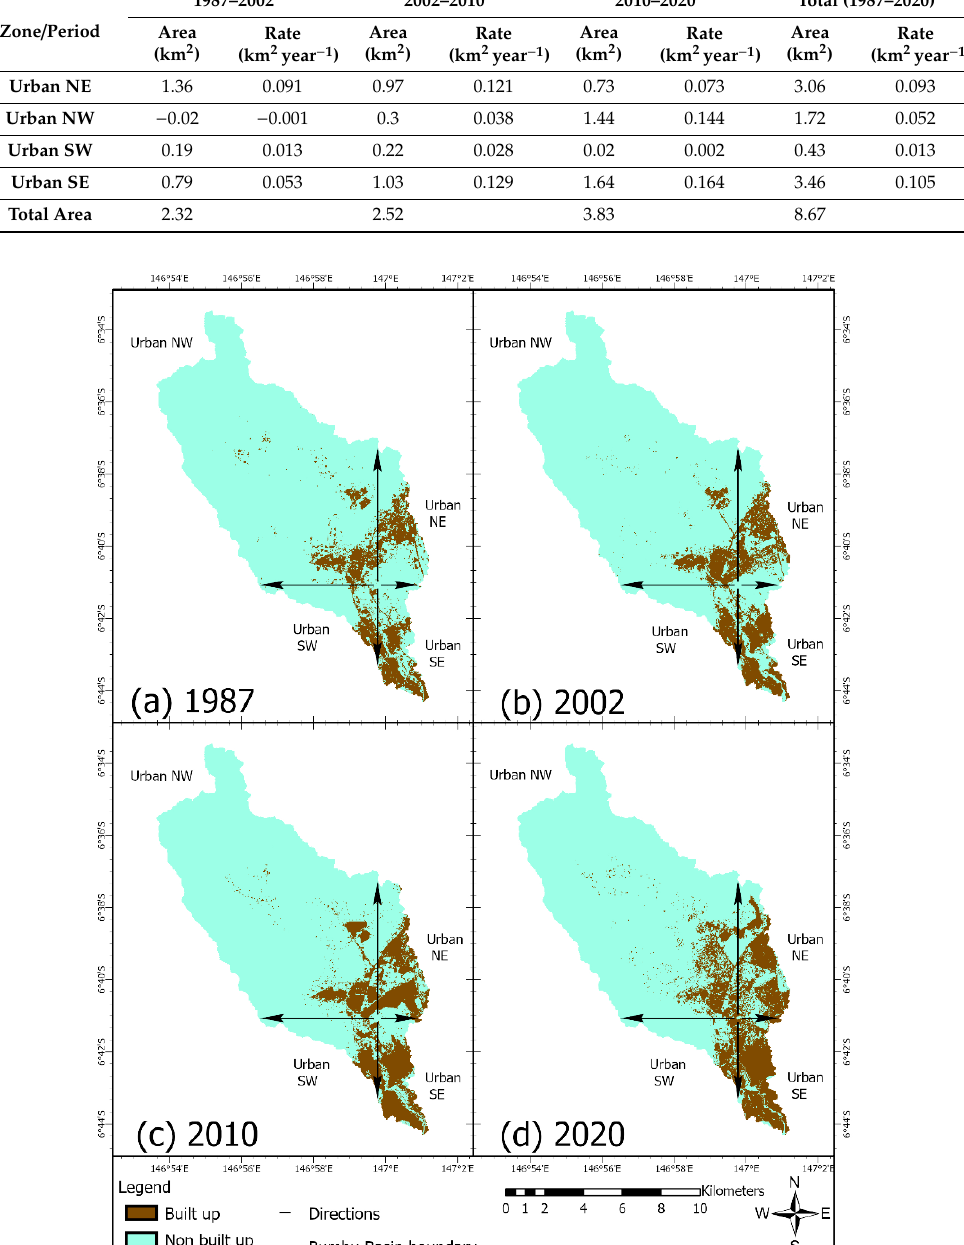
Figure 4. The spatial extent of the urban area in Bumbu basin in the years ( a ) 1987, ( b ) 2002, ( c ) 2010, and ( d ) 2020.